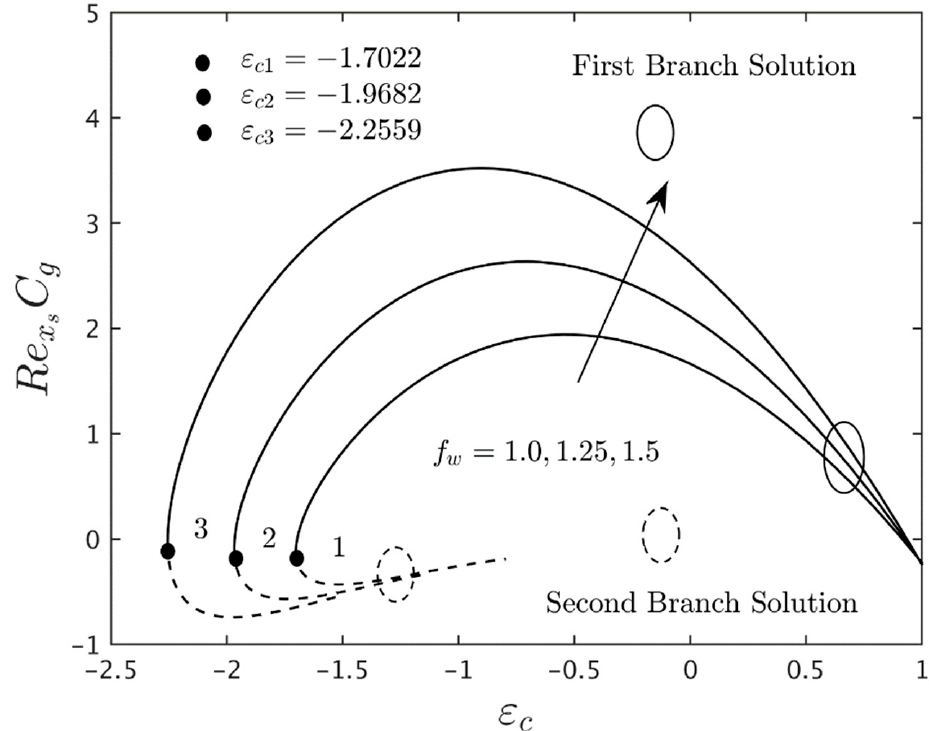
for the several values of the c